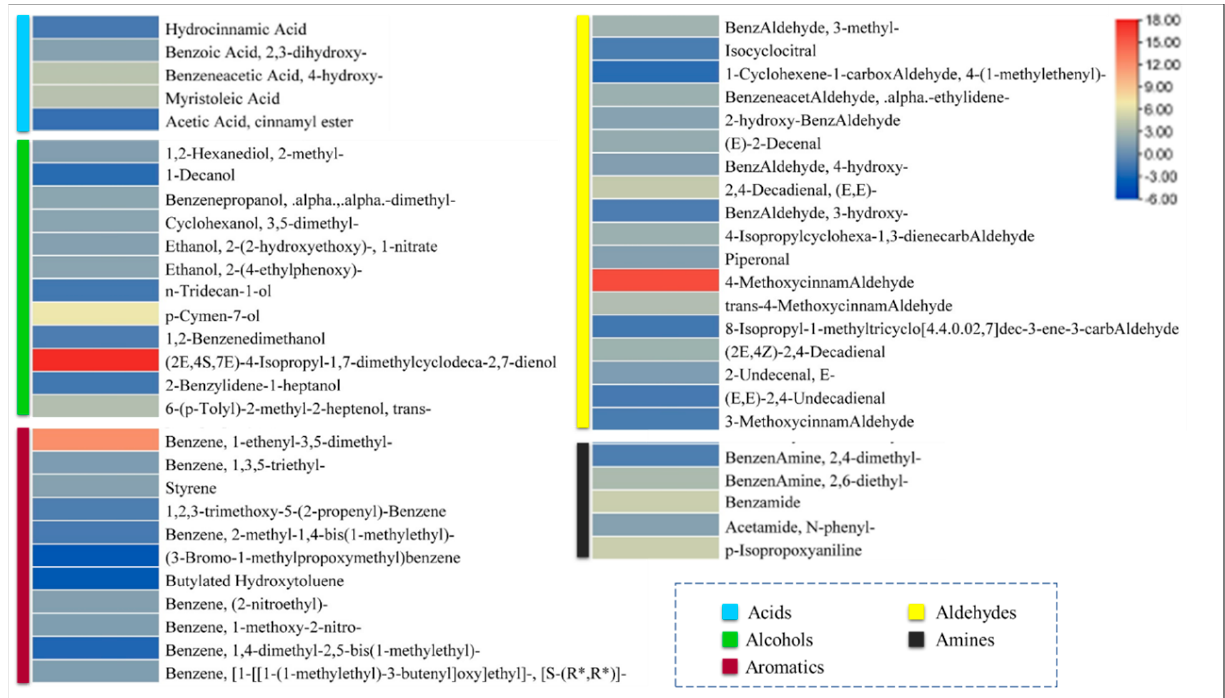
Figure 4. Heatmaps of the log2 foldchange values of acids, alcohols, aromatics, aldehydes, and amines that were differentially accumulated in C. x sinensis peels vs. C. reticulata peels. The colored bars on the right side of the heatmaps represent compound classes.